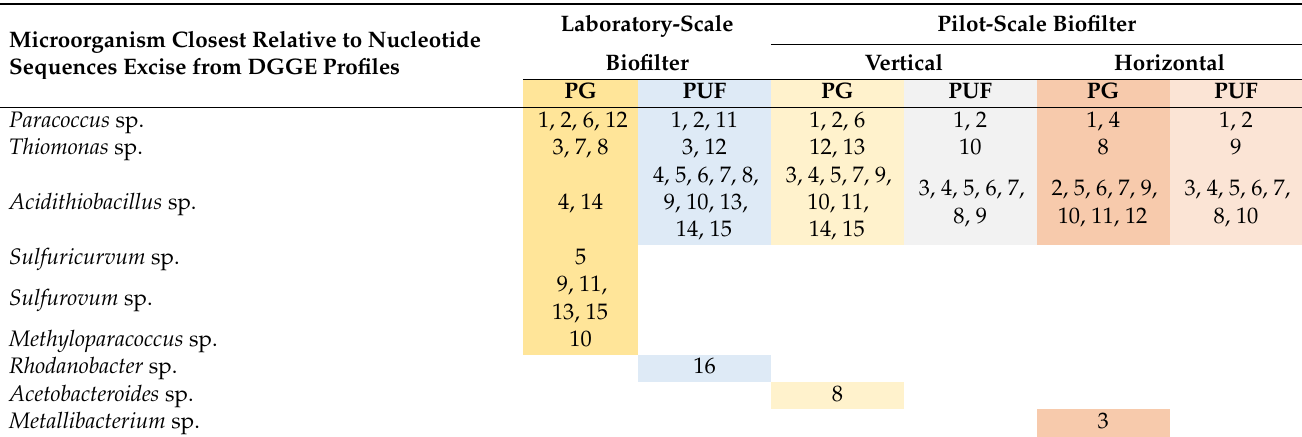
Table 3. Identification of nucleotide sequences obtained from DGGE